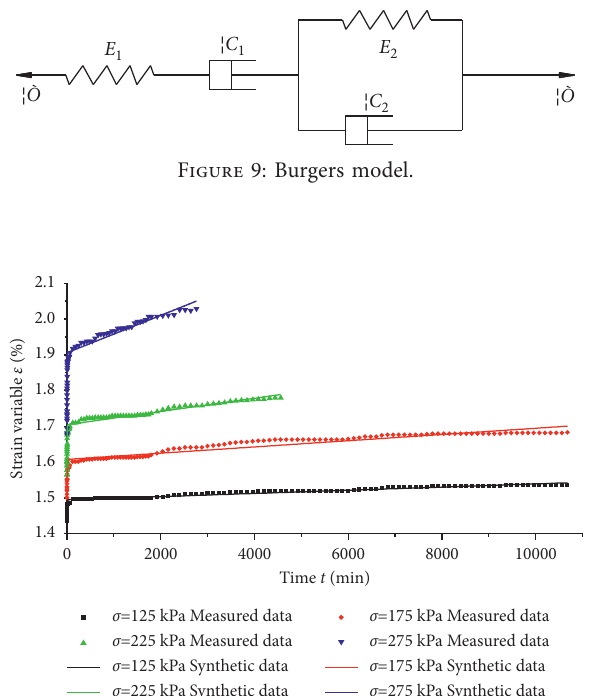
Figure 10: Fitting analysis with the Burgers model.